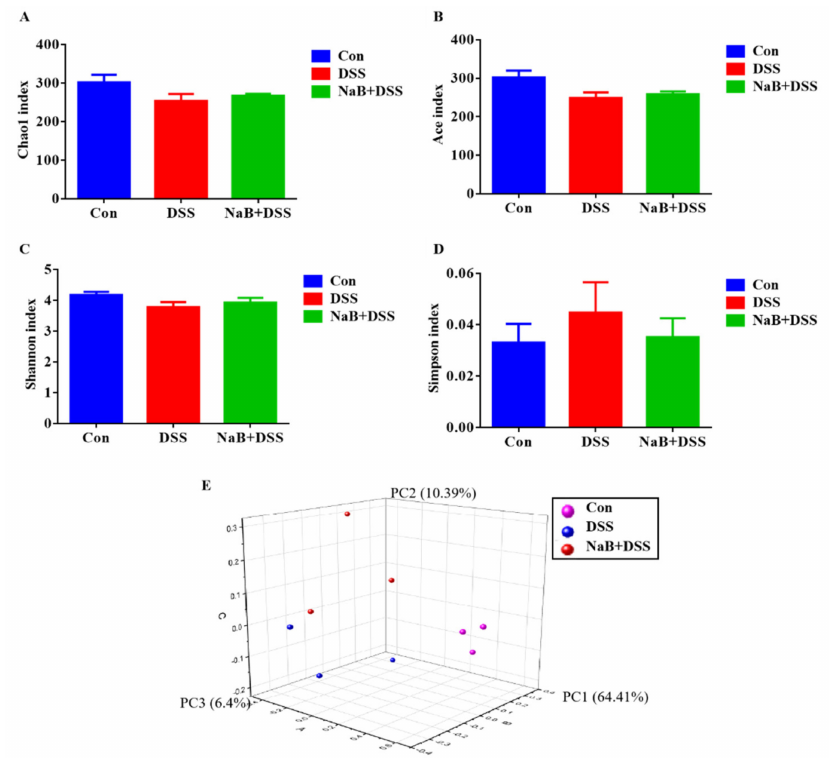
Figure 2. NaB altered microbial diversity in the colitic mice. The alpha diversity indices included the ( A ) Chao 1 estimator; ( B ) ACE index; ( C ) Shannon index; ( D ) Simpson index; and ( E ) PCoA of β diversity of cecal bacteria. Con, control treatment; DSS, DSS treatment under the control treatment conditions; NaB + DSS, dietary addition of NaB followed by DSS treatment. Values are shown as the mean ± SD or the median with the 95% confidence interval ( n =